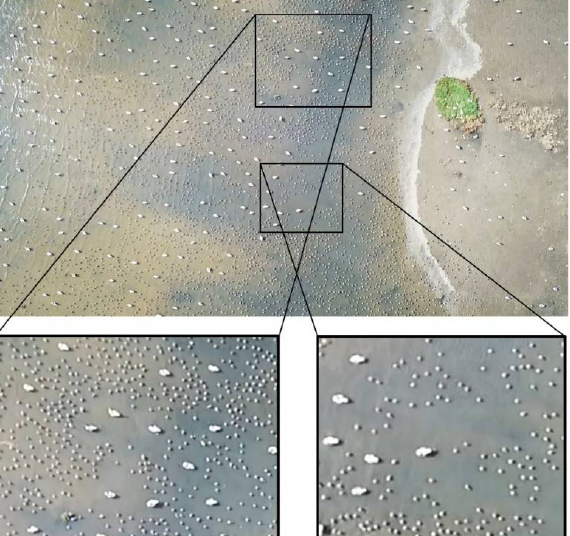
Figure 2. Example of an orthomosaic with two excerpts, which was generated from the UAS surveys on field day 1 (27 September). Two species, dunlin and shelduck, were present on the roost site. Precise spatial positioning was readily obtainable, which enabled the subsequent fine-scale calculation of species-specific density estimations. Note the alterations for the density distribution of dunlin, when close to the more evenly distributed individuals of Shelduck, which indicates dynamic interactions between the two species on the roost